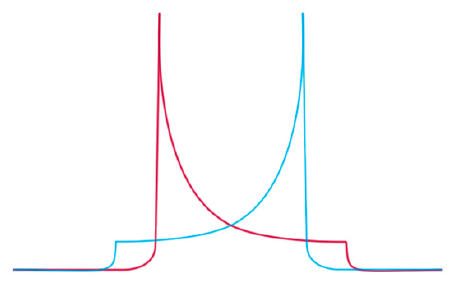
Figure 14. Pake pattern, displaying the two line shapes that compose it.